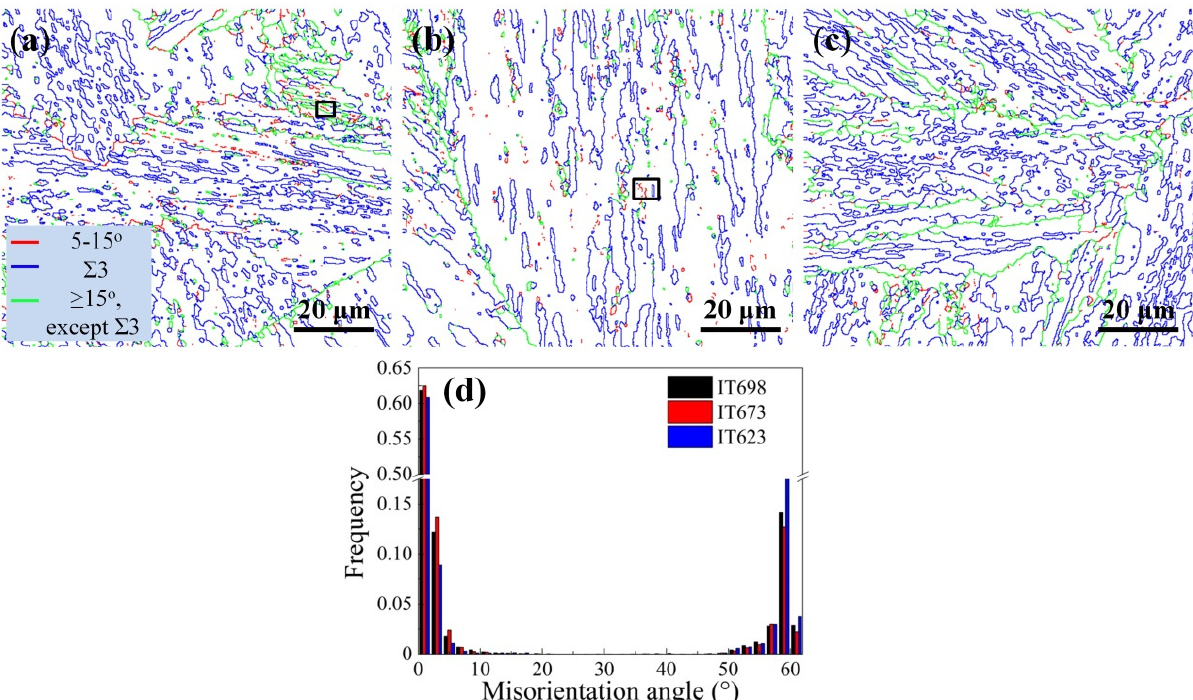
Figure 5. ( a – c ) GB maps and ( d ) the distribution of boundary misorientation angle of ( a ) IT698, ( b ) IT673 and ( c ) IT623. The regions selected by black squares will be analyzed in detail below. The region belonging to a prior austenite grain was extracted using the (001) γ stereo- graphic projection on which <001> α with a K–S OR to austenite were plotted. Compared with the standard (001) γ stereographic projection [4], the individual variant can be identi- fied. The IPF maps, corresponding (001) γ pole figure, CP map and Bain maps are illustrated in Figure